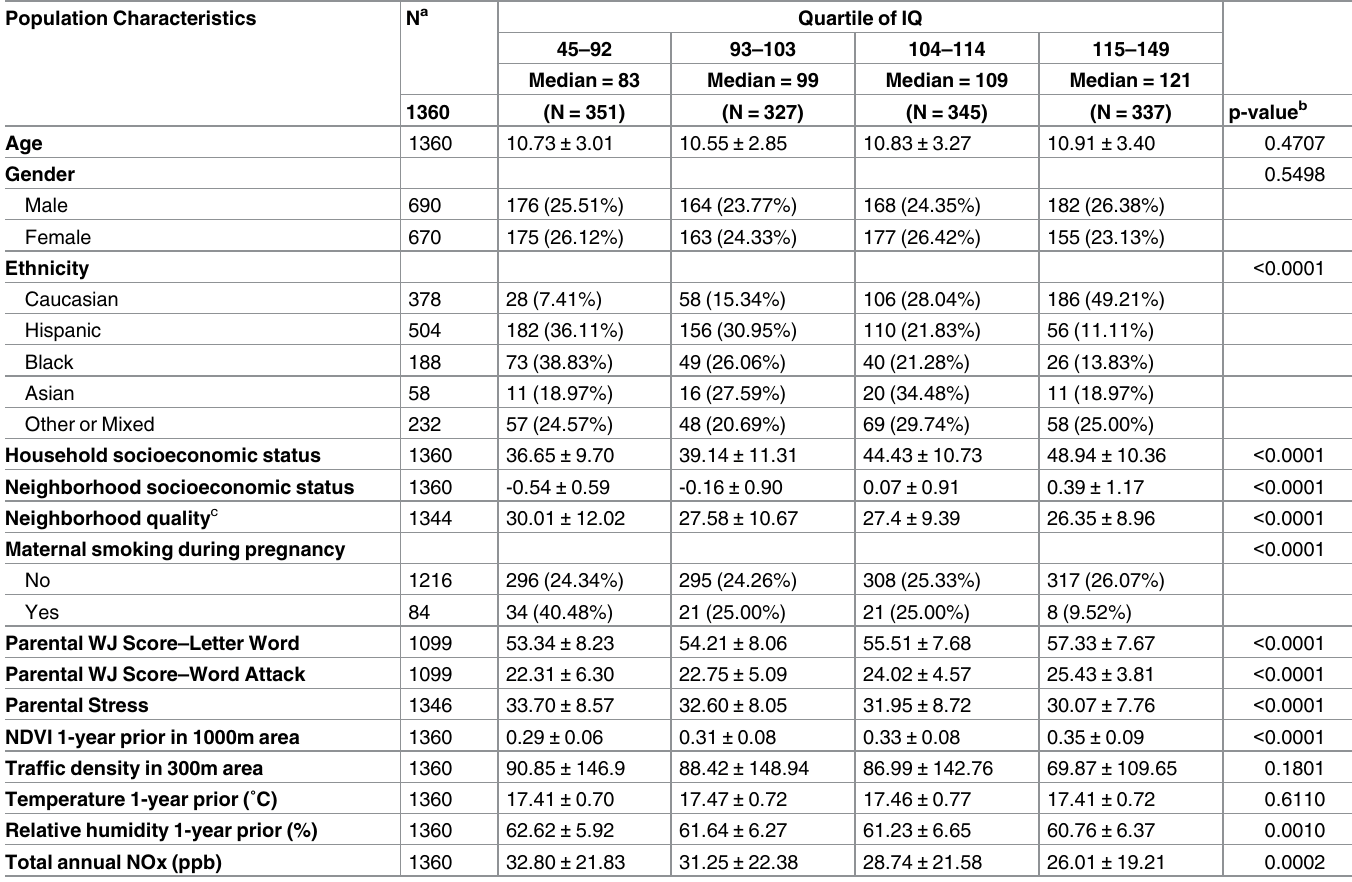
Table 2. Population characteristics at baseline in relation to full-scale